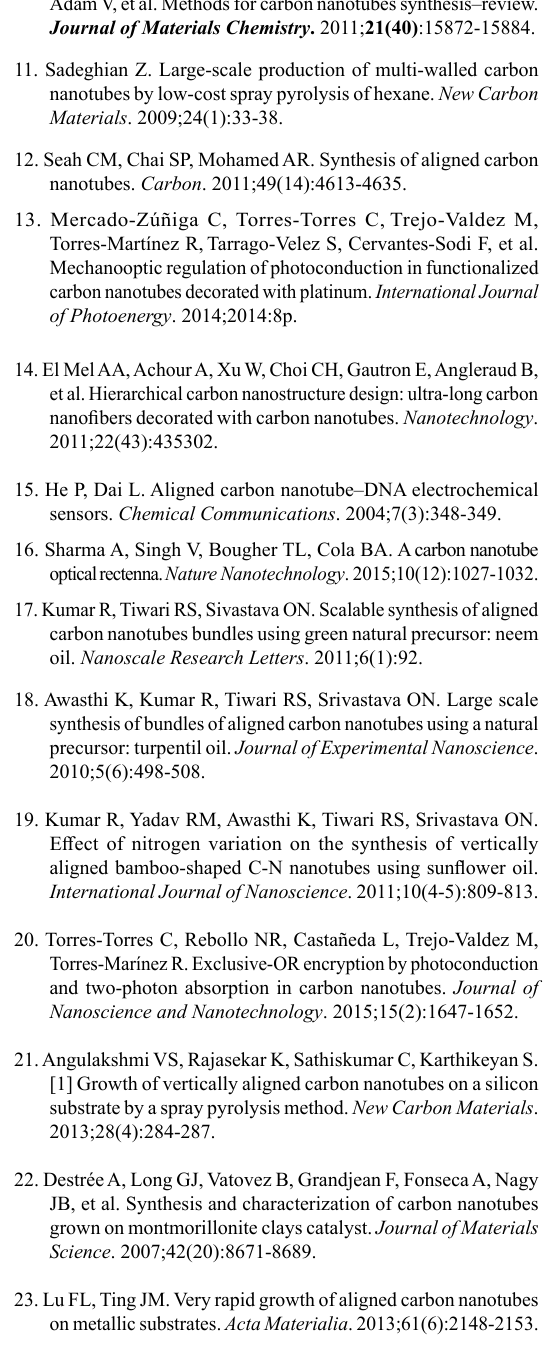
Table 1: Representative variations of the nonlinear optical absorption coefficient, β , estimated for an array of vertically aligned carbon nanotubes in a two-wave mixing interaction at 532 nm wavelength of excitation. Here the spatial period of the fringe irradiance pattern is T , and the spatial period of the aligned carbon nanotubes is T f